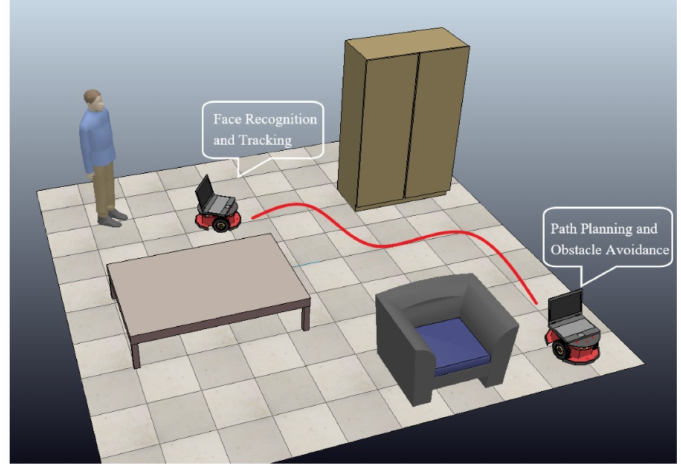
Figure 1. Research